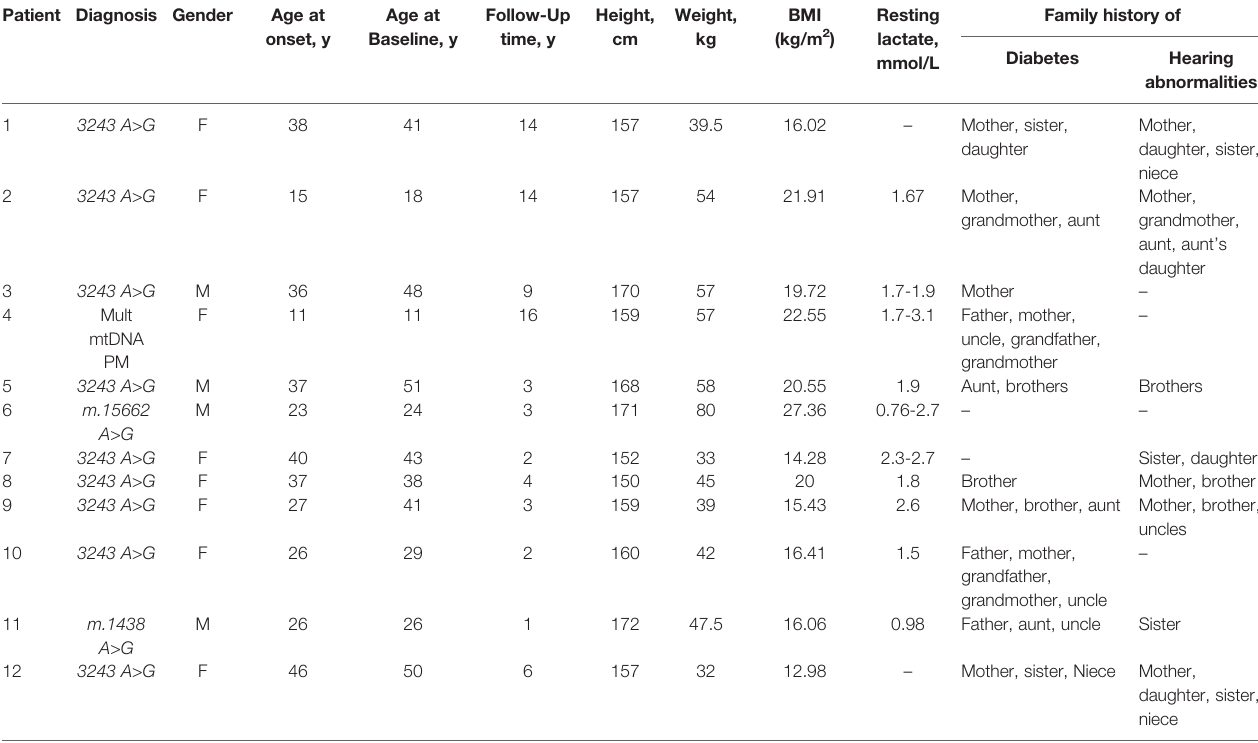
TABLE 1 | Demographic and clinical characteristics of 12 patients with MD. Patient Diagnosis